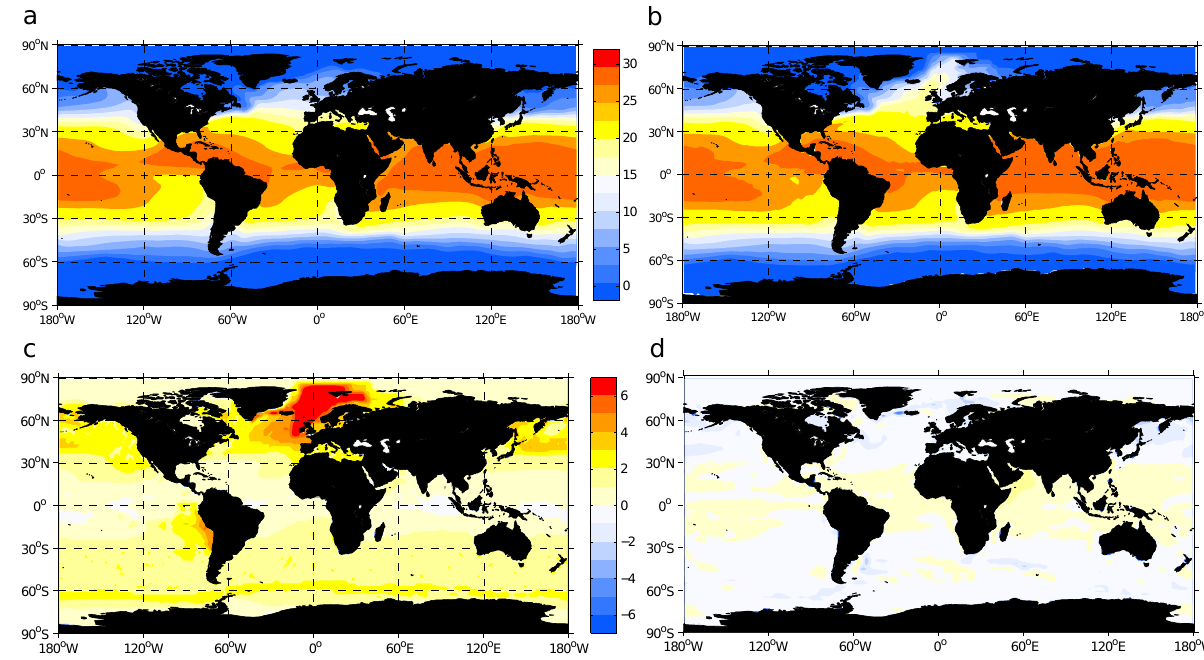
Fig. 5. Boundary conditions. Absolute annual global sea surface temperatures [ ◦ C] for (a) pre-industrial ( SST pre.genesis ), and (b) mid- Pliocene ( SST plio.genesis ) experiments. Mid-Pliocene final SSTs are calculated using an anomaly approach (see text). Differences in annual SSTs [ ◦ C] (c) between (b)-(a), and (d) between GENESIS pre-preindustrial ( SST pre.genesis ) and PRISM pre-industrial dataset ( SST pre.prism ).